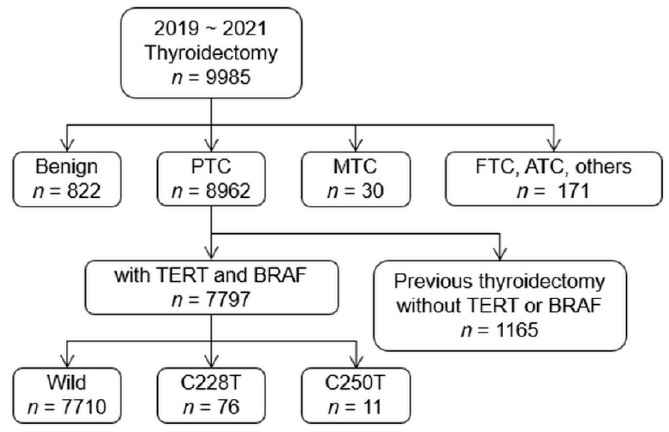
Figure 1. Initial process of patients’ selection for the study.